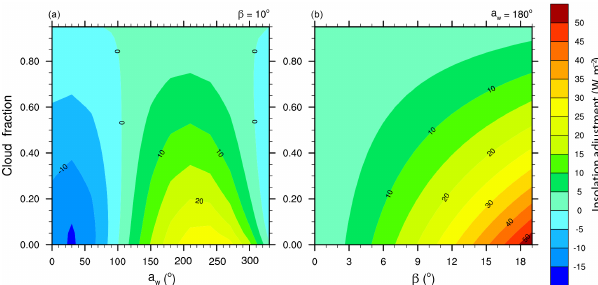
Figure 10. The effect of cloud fraction on daily average tilt correc- tion of insolation changing with (a) tilt direction ( a w ) and (b) tilt angle ( β